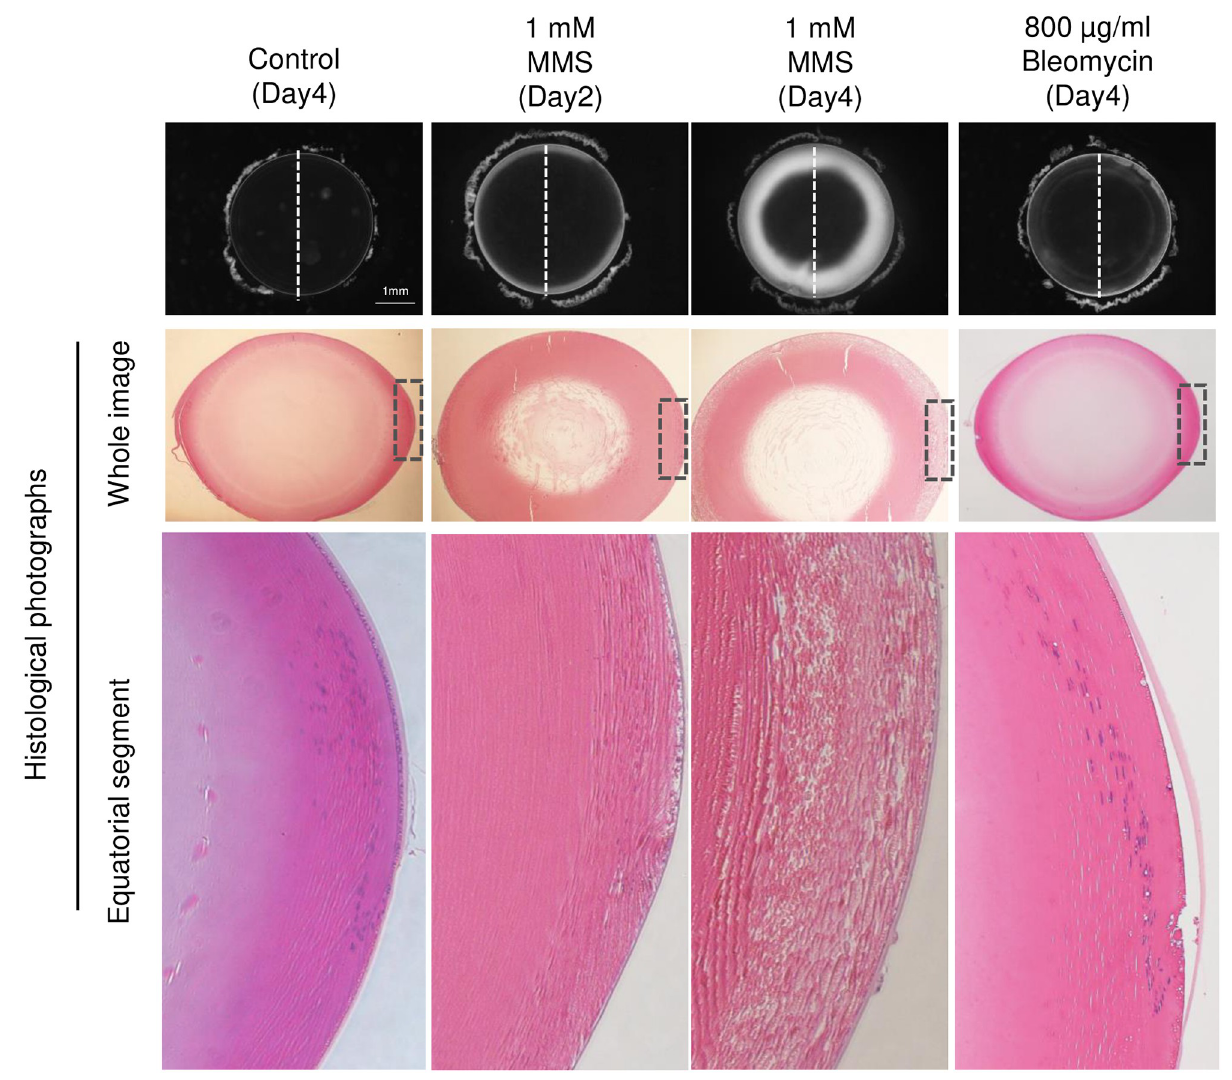
Fig 2. Cross-sectional morphology of lenses subjected to MMS or Bleomycin. The images in the top row show micrographs of the lenses. The images in the middle row show whole images of hematoxylin and eosin (H&E) stained paraffin cross-sections that were sectioned in the direction indicated by the dashed line on the micrographs (HE). The images in the bottom row are enlarged images of the equatorial part of the section image in the middle row, denoted by areas surrounded with dashed lines.